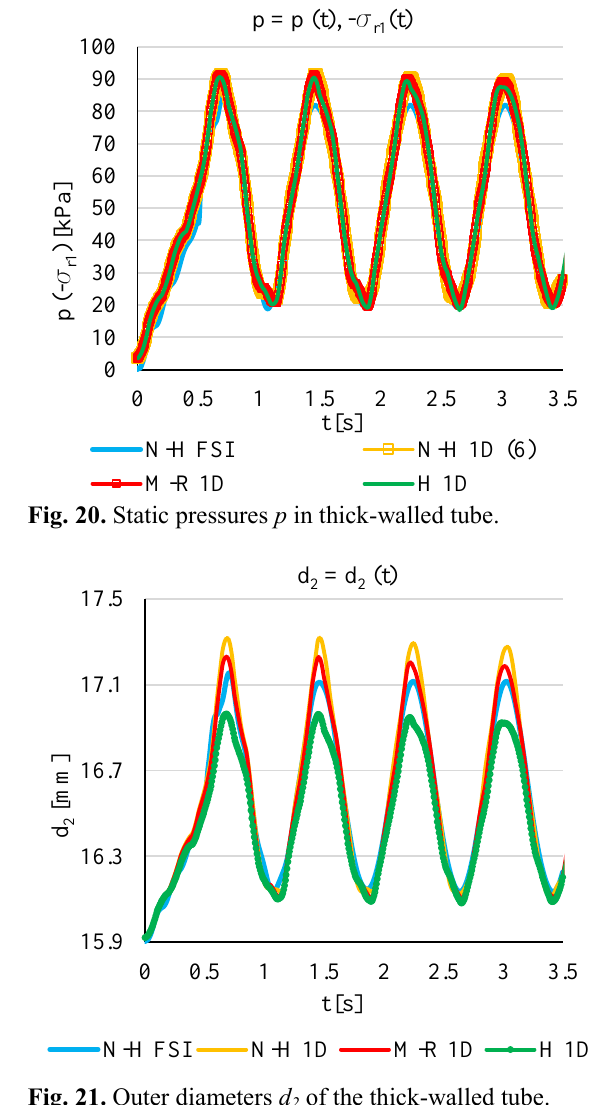
Fig. 21. Outer diameters d 2 of the thick-walled tube.